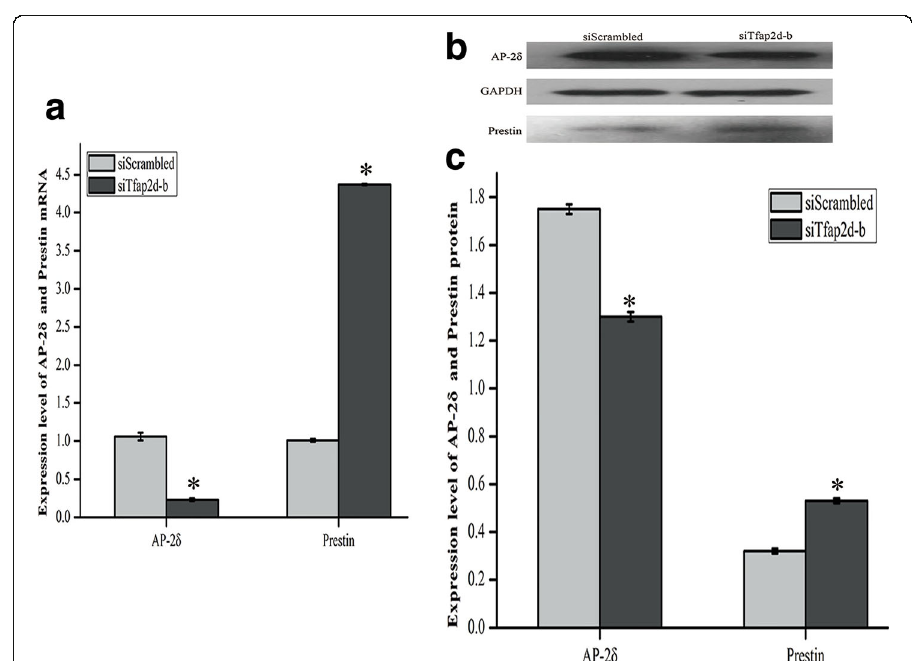
Fig. 5 AP-2 δ negatively regulated the transcription of Prestin. a HEI-OC1 cells were transfected with the siTfap2d-b fragment for 24 h and subjected to qRT-PCR to detect the expression level of AP-2 δ and Prestin mRNA. b Representative western blot of AP-2 δ and Prestin from cells treated with siTfap2d-b. GAPDH was used as an endogenous control. These images came from the same gel. c Expression level of AP-2 δ and Prestin protein in HEI-OC1 cells treated with siTfap2d-b. The data were normalized to GAPDH expression, and they were presented as the means±SD; n = 3 each group. * represents P < 0.05 compared with the group treated with the siScrambled